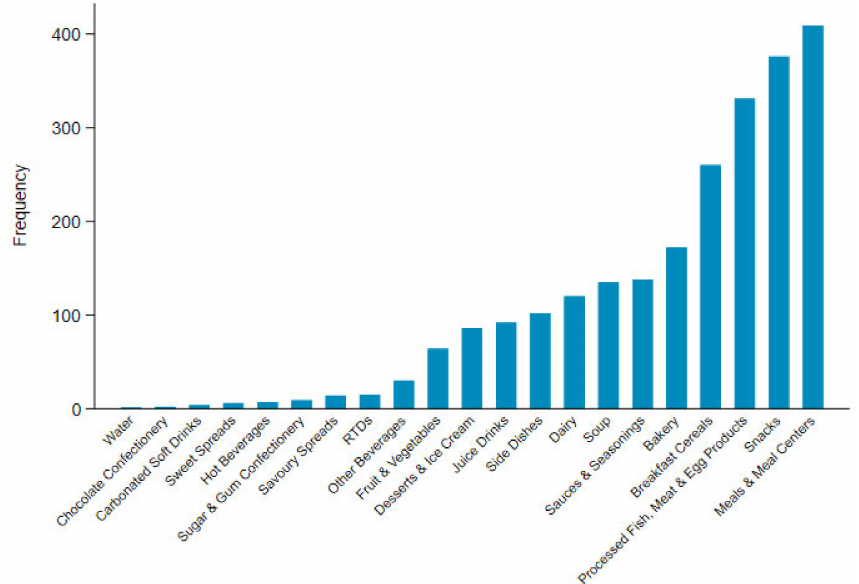
Figure 3. Frequency of UP products scoring a Health Star Rating ≥ 2.5 by Mintel